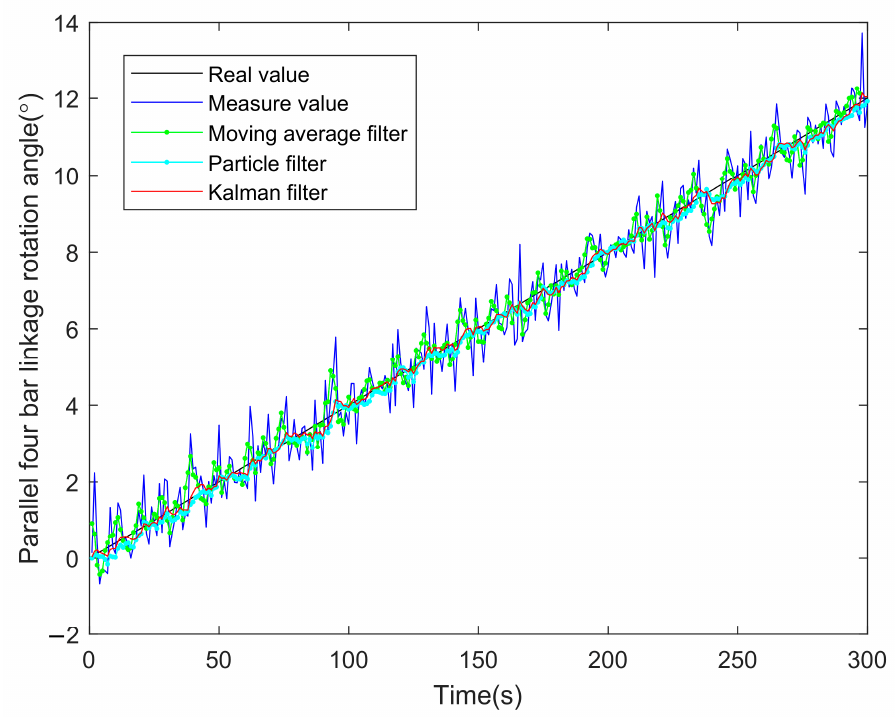
Figure 4. Parallel four-bar linkage rotation angle simulation.